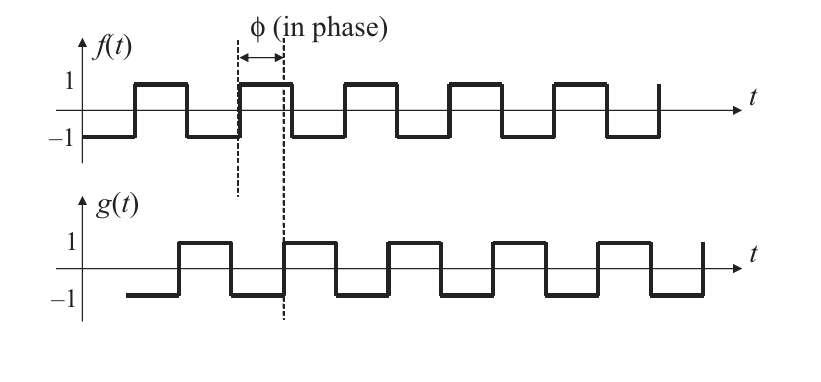
Figure 3. The reference signal f(t) and the output signal g(t).